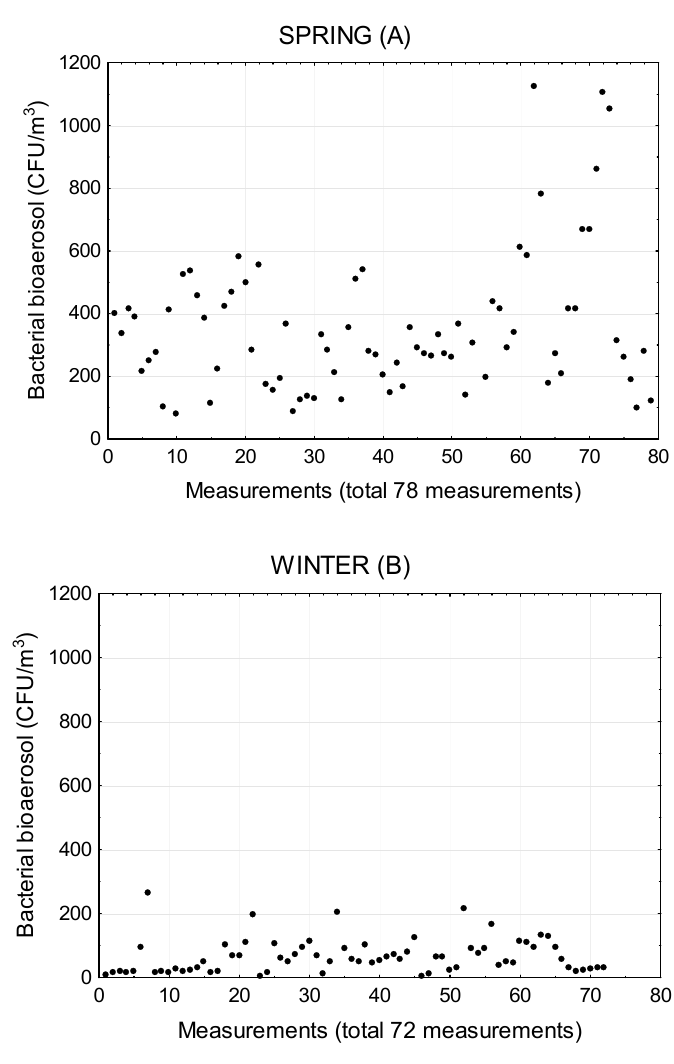
Figure 2. Concentration of culturable bacterial aerosols in outdoor air in spring ( A ) and winter ( B ).